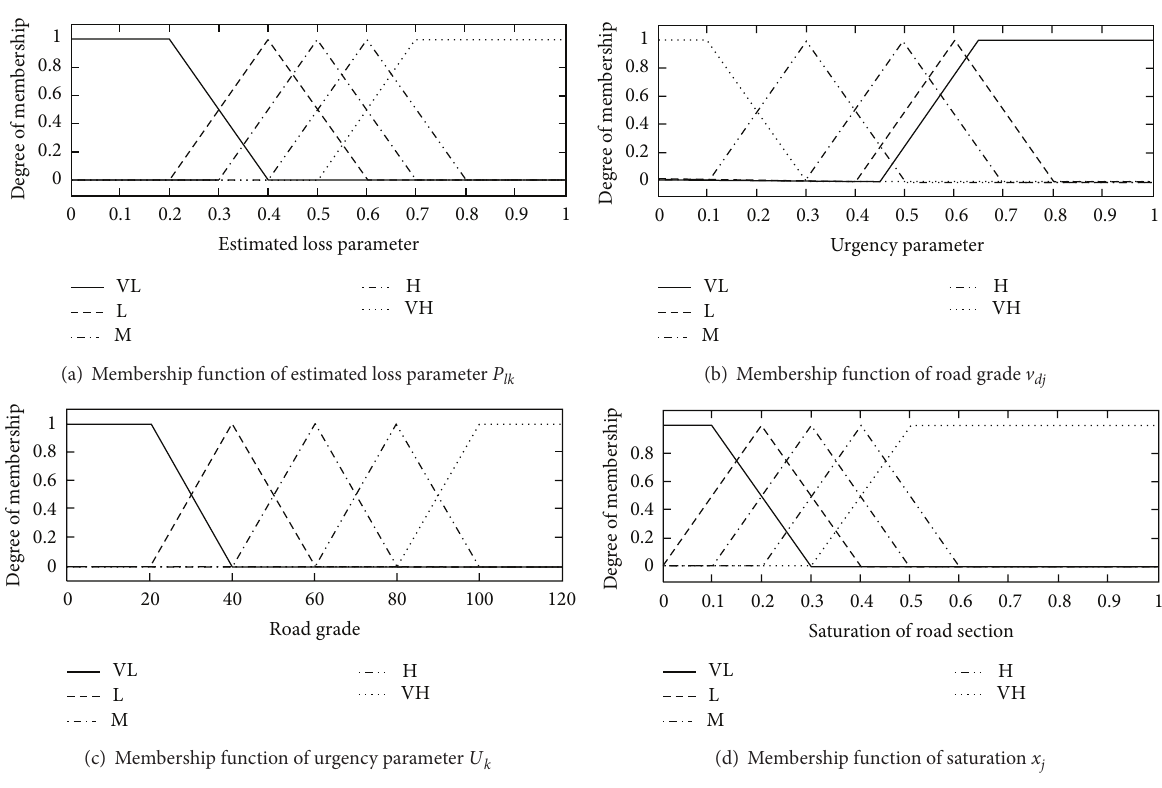
Figure 3: Membership function in degree of priority classification